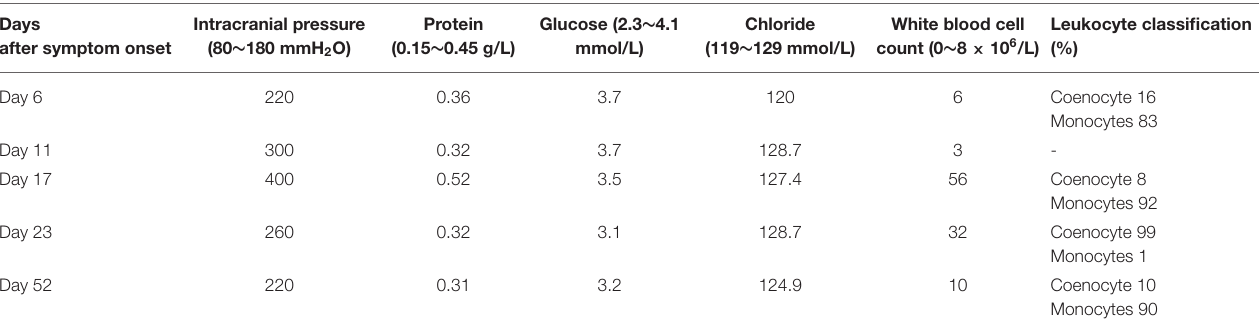
TABLE 1 | Cerebrospinal fluid examination.